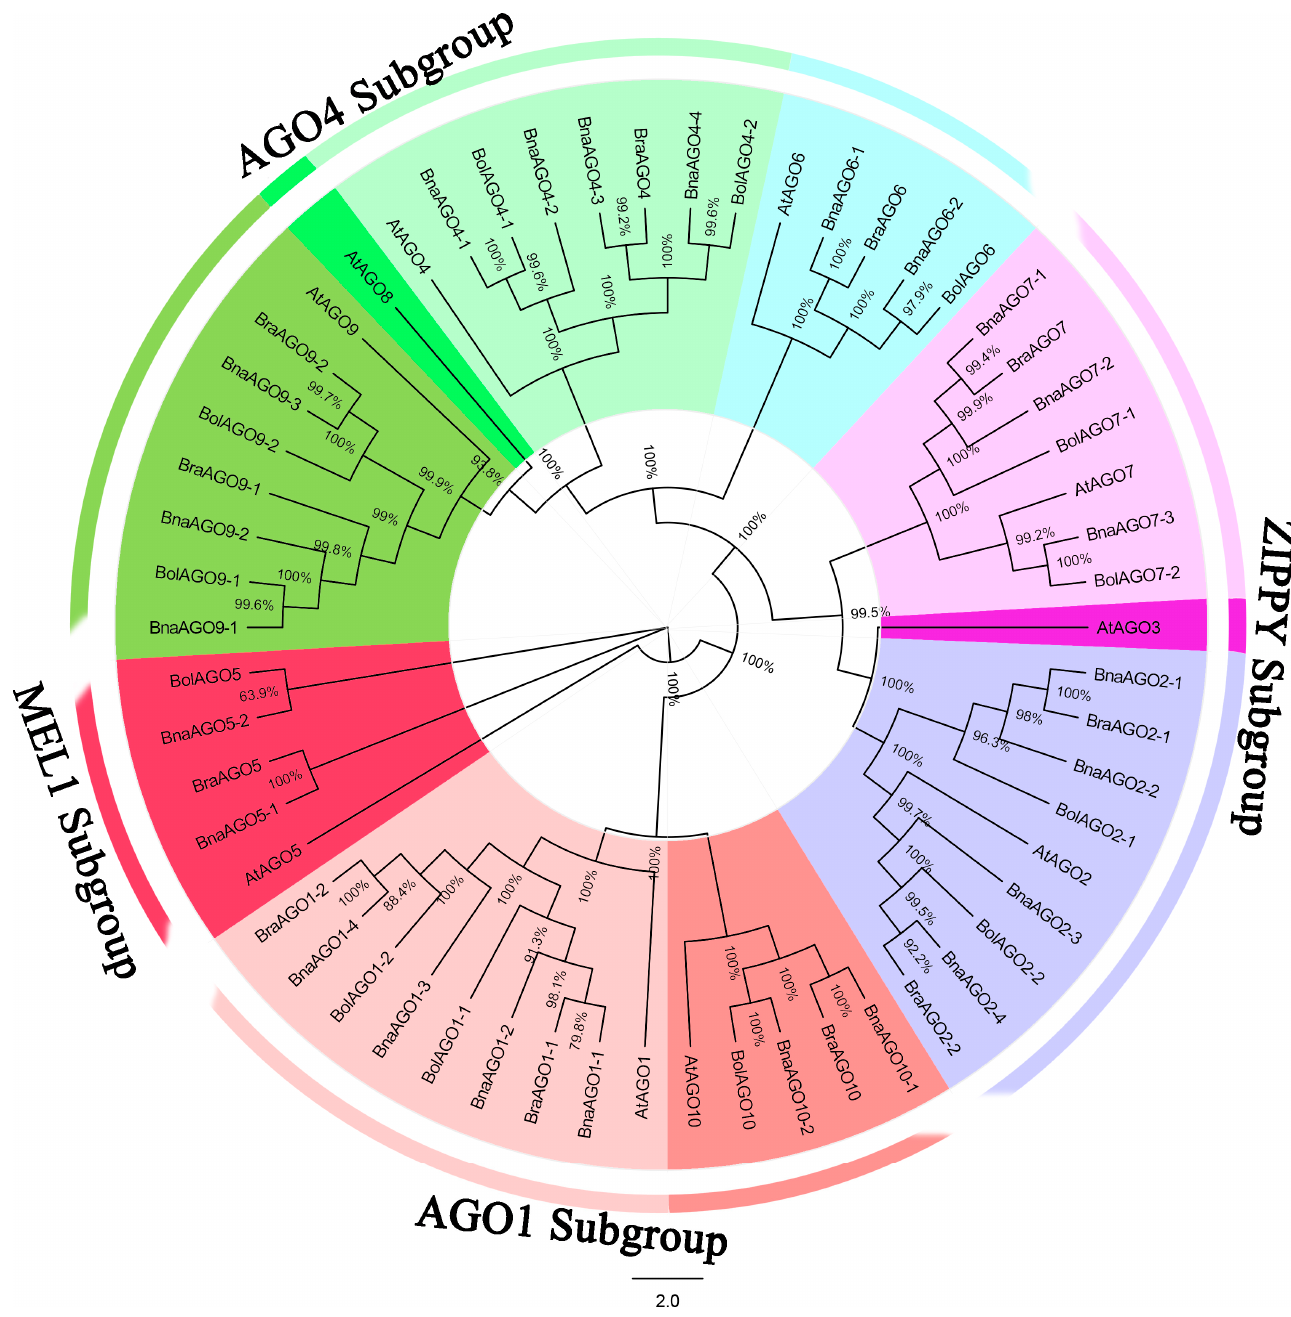
Figure 1. Neighbor-joining (NJ) tree of the Argonaute (AGO) protein sequences from B. napus , B. oleracea , B. rapa and A. thaliana . All the AGO genes were renamed from AGO1 to AGO10. A syntenic analysis was performed to further determine the evolutionary relation- ship of the AGO family among the four species. A total of 77 homologous pairs were iden- tified among the four species (Figure 2A, Table S2), with significantly more homologous pairs found in the A subgenome than that in the C subgenome (Figure 2B,C). All of the AGO copies in B. napus corresponded to those of the progenitors B. oleracea and B. rapa, with the exceptions that AGO9 was missing in B. napus and AGO4 was not present in the progenitors (Table 1). The 24 BnaAGO s were distributed across the 16 chromosomes, with the exception of chromosomes A01, C01, and C09 (Figure 2D).